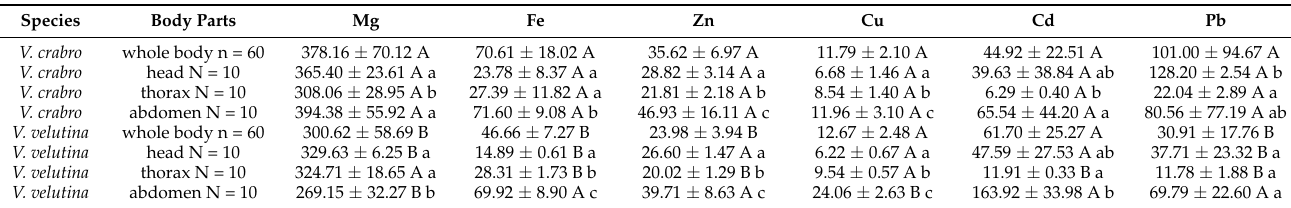
Table 1. Element concentrations in the adult European hornet ( V. crabro ) and Asian yellow-legged hornet ( V. velutina ). Data are reported as mean ± standard deviation (SD), and are expressed in µ g/g wet weight (ww) for Mg, Fe, Zn and Cu and in ng/g ww for Cd and Pb. For each metal, different capital letters indicate significant differences between species. For each metal, different lower cases indicate a significant difference among body parts within each species.